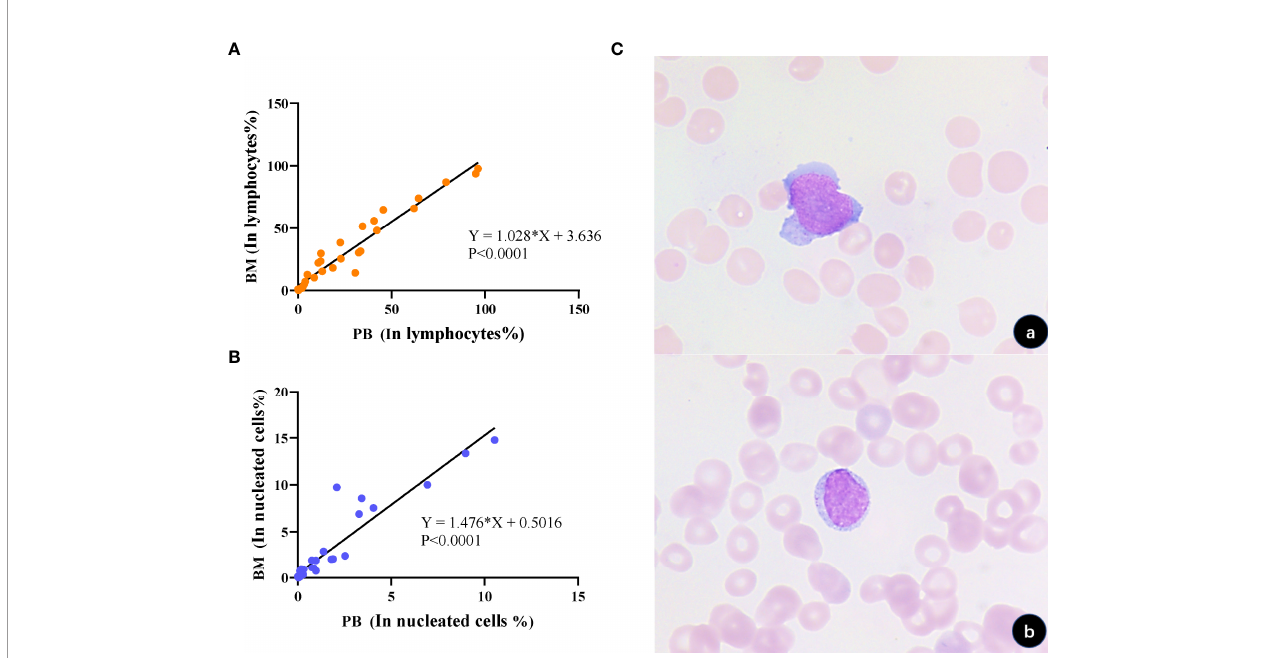
FIGURE 5 | Correlation and homology of tumorigenic NK cell load in the bone marrow and peripheral blood. (A) Correlation analysis of the proportion of tumorigenic NK cells occupying lymphocytes in the bone marrow and peripheral blood, respectively, showed a positive correlation (p < 0.0001). (B) Correlation analysis of the proportion of tumor NK cells occupying nucleated cells in the bone marrow and peripheral blood, respectively, showed a positive correlation (p < 0.0001). (C) Morphological analysis veri fi ed that tumor cells in the bone marrow and peripheral blood had similar morphology (a, BM; b, PB;